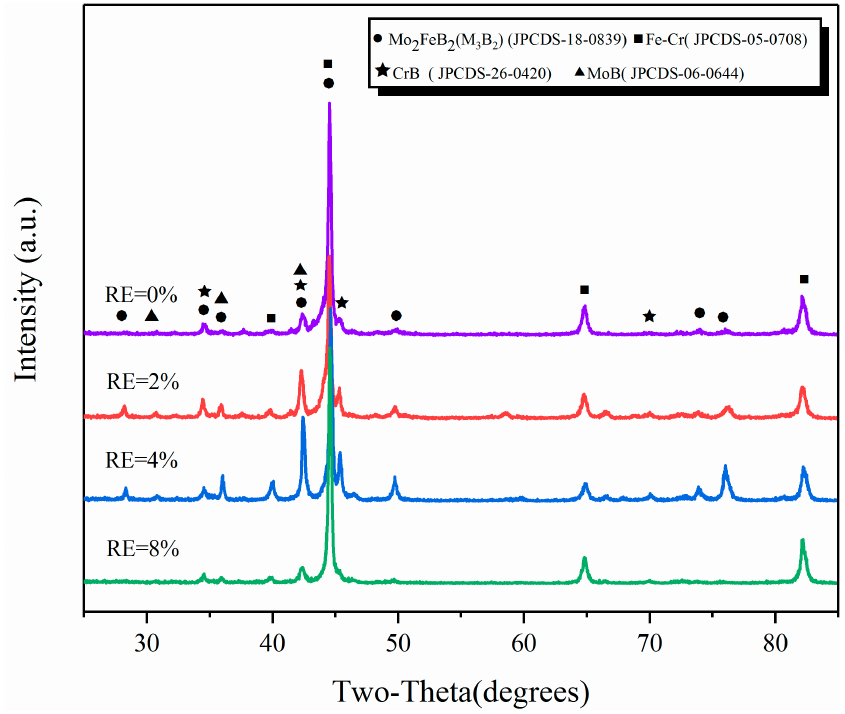
Figure 2. XRD analysis of claddings with different RE content.